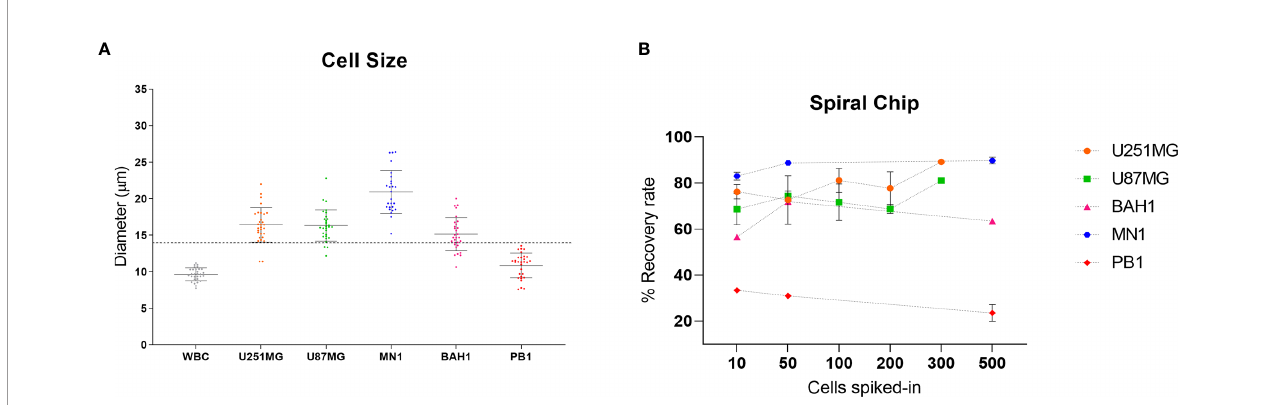
FIGURE 1 | Recovery studies using GBM cell lines. (A) Cell size distribution of fi ve different GBM cell lines (U251MG, U87MG, MN1, BAH1 and PB1) and white blood cells (WBCs). Cells were harvested and plated into a 96 well plate. Cell diameter was measured using Nikon Eclipse Ti-S. Software NIS-Elements, n = 30. The dashed line represents the cutoff of the spiral micro fl uidic device used (14 µm). (B) Spiral Chip recovery rates. Different numbers of GBM cell lines labelled with a Cell Tracker ™ Green CMFDA (5-chloromethyl fl uorescein diacetate) (Life Technologies, USA) were spiked into whole blood and/or directly into WBCs. Samples were pumped through the spiral chip at 1.7ml/min. All volume was distributed into a 96 well plate and counted using fl uorescence microscopy (Nikon Eclipse Ts2). Recovery rates were calculated as the total of labelled cells found in the CTC-output/total of labelled cells from both outputs. For U87MG and U251MG recovery rates using 10, 50, 100, 200 cells, n = 3. For 300 cells, n = 1. For MN1, BAH1 and PB1 recovery rates using 500 cells and 10 cells for MN1, n = 2. For recovery rates using 10 and 50 cells (BAH1, PB1), n = 1. Error bars indicate the standard deviation from the mean value across replicates.